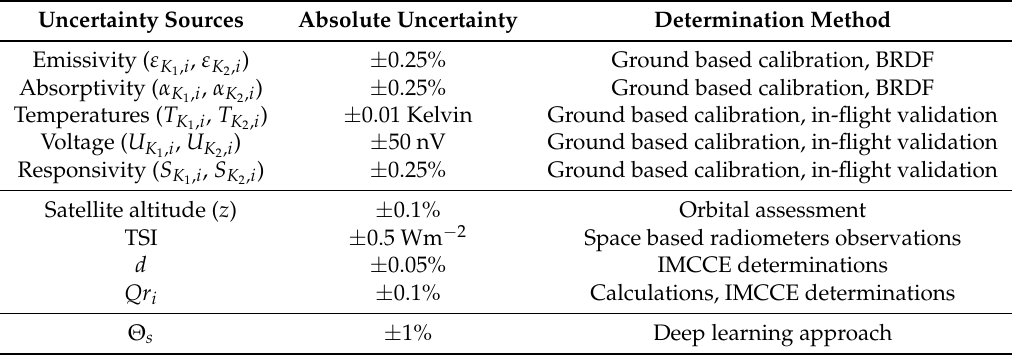
Table 3. Error budget of the ERS